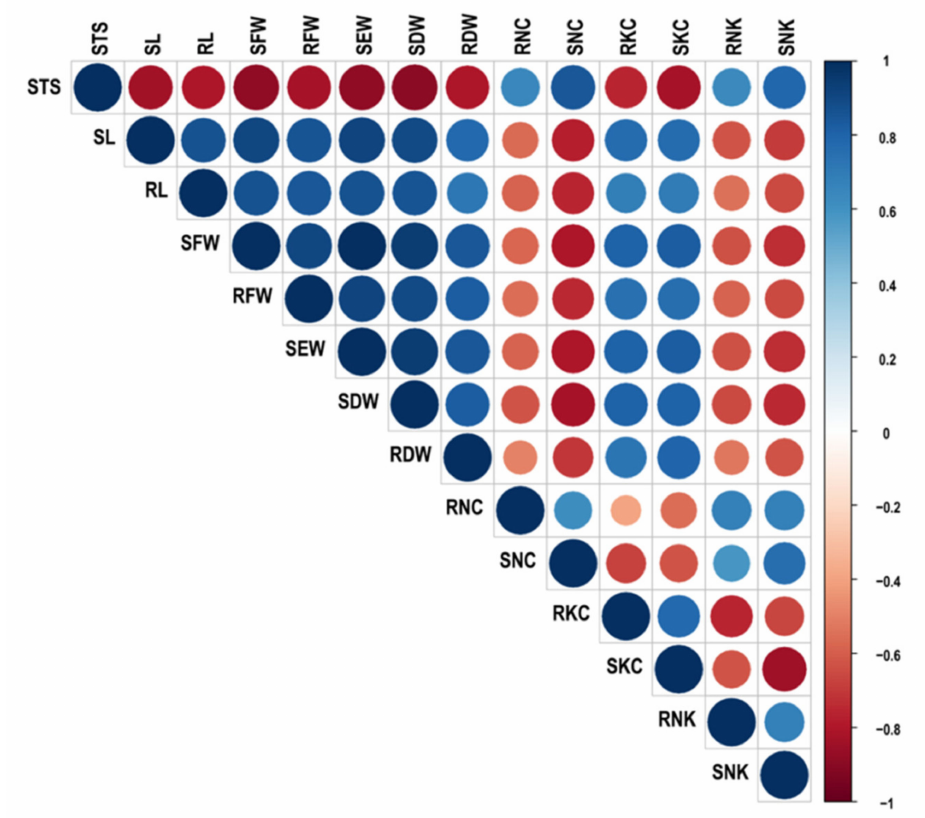
Figure 3. Correlation coefficients among various morpho-physiological parameters under salt stress condition. Positive correlations are displayed in blue and negative correlations in red color. Color intensity and the size of the circle are proportional to the correlation coefficients. In the right side of the correlogram, the legend color shows the correlation coefficients and the corresponding colors. STS, Salinity tolerance score; SL, shoot length (cm); RL, root length (cm); SFW, shoot fresh weight (g); RFW, root fresh weight (g); SEW, seedling weight (g); SDW, shoot dry weight (g); RDW, root dry weight (g); RNC, root Na + content (mmol/g); SNC, shoot Na + content (mmol/g); RKC, root K + content (mmol/g); SKC, shoot K + content (mmol/g); RNK, root Na + /K + ratio; SNK, shoot Na + /K +